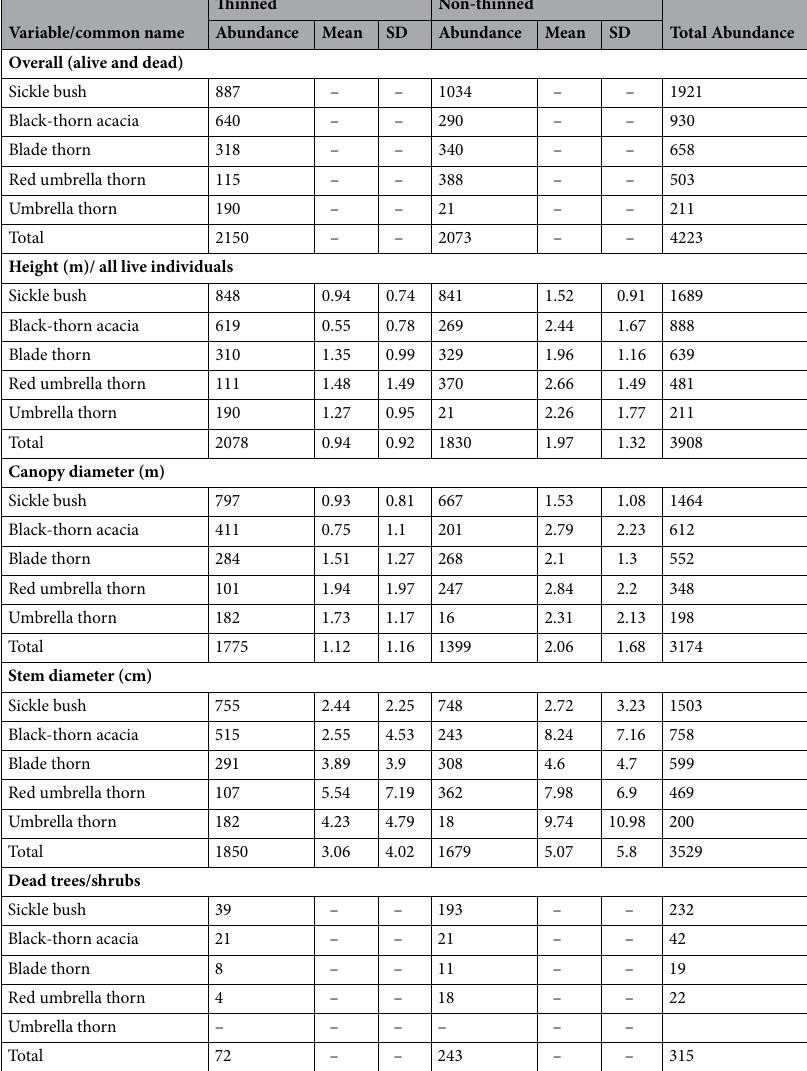
Table 1. Observations of trees/shrubs by species and measured structural characteristics in the thinned and non-thinned treatments. The number of trees/shrubs counted are indicated as abundances; the height, canopy and stem diameters are expressed as averages (mean) with associated standard deviation (SD) values for each species in the non-thinned and thinned